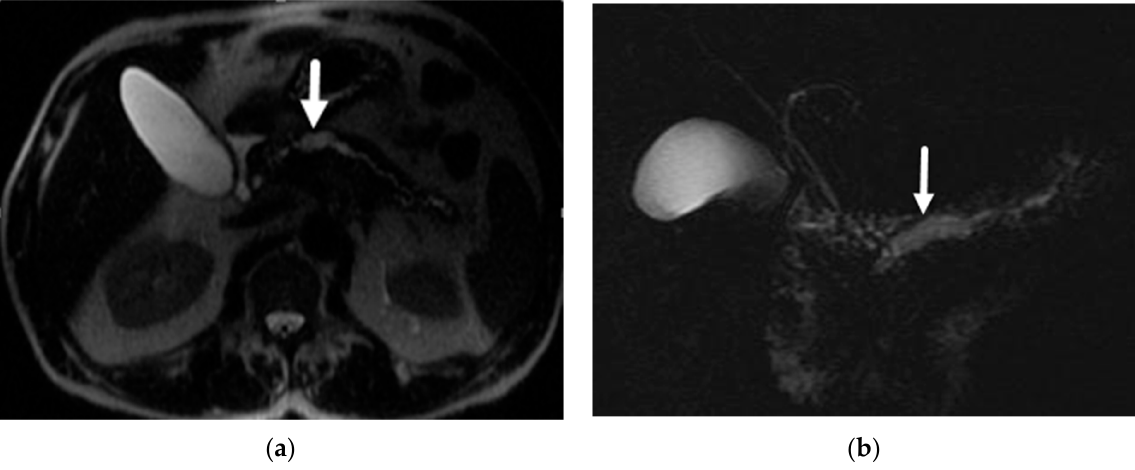
Figure 2. Main duct IPMN. ( a ) Axial T2-wieghted image demonstrates focal dilatation of the PD in the body (arrow). ( b ) MRCP demonstrates the focal dilatation in relation to the rest of the duct.